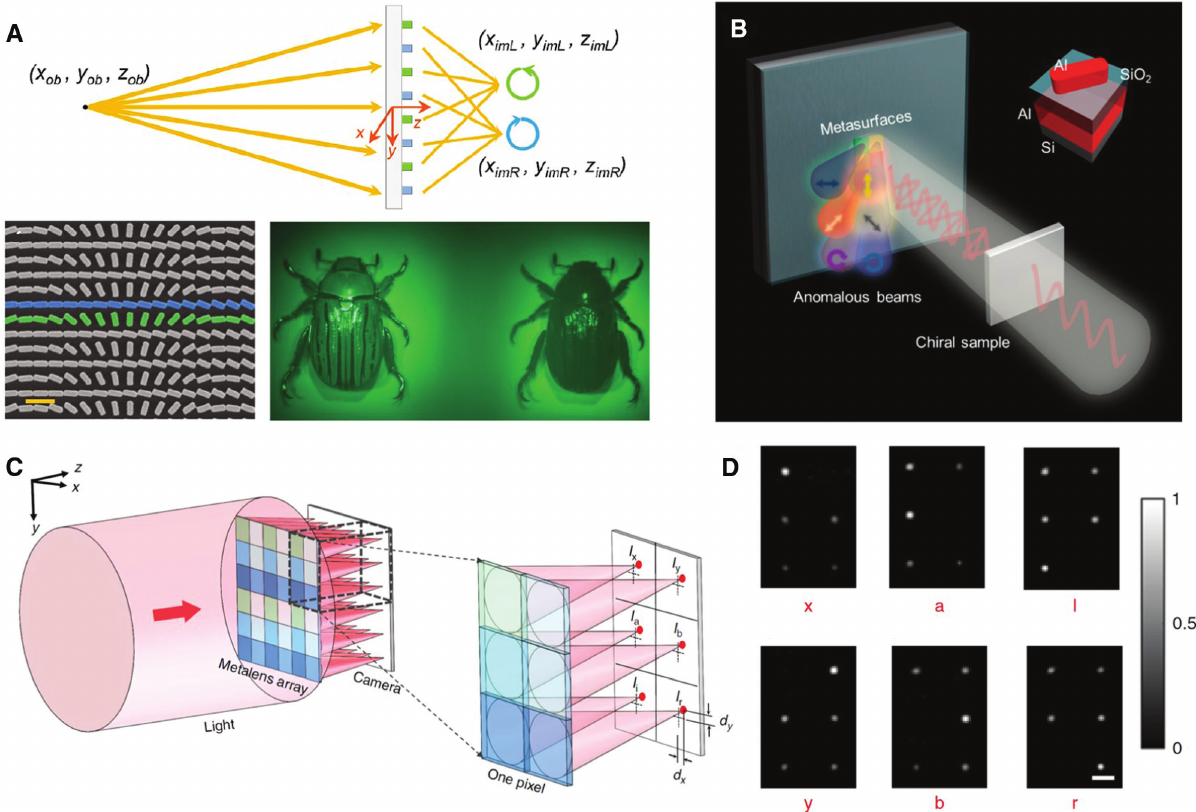
Figure 2: Optical metasurfaces for polarimetric imaging and wavefront sensors. (A) Top: schematic diagram illustrating the imaging principle of the multispectral chiral lens (MCHL) where left circular polarization (LCP) and right circular polarization (RCP) light from the same object at coordinates (x (x , y , z ) and (x , y , z ), respectively. Bottom left: scanning electron microscopy image of the fabricated MCHL. Scale bar: 600 nm. imL imL imL imR imR imR The two interlaced arrays of nanofins are false-colored. Bottom right: experimental results from [90]. (B) Schematic illustration of the on-chip polarimetry with integrated metasurfaces that can work at visible light [91]. (C) Scheme of the generalized Hartmann–Shack beam profiler. Each pixel of the array shown on the left consists of six different polarization-sensitive metalenses and (D) measured images of the resulting focal spots for incident horizontal or vertical linear polarization (“x” and “y”), diagonal linear polarization (“a” and “b”), and circular polarization (“l” and “r”) [93]. Reprint permission obtained from [90, 91,